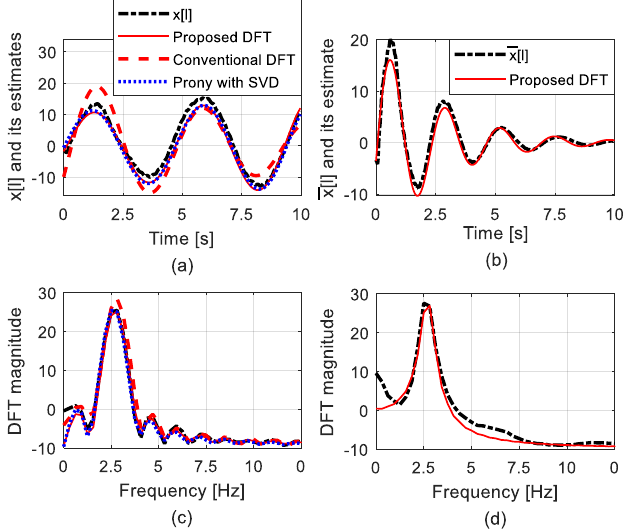
Figure 8. Modal oscillation signal and its estimated signals in the Central American power system: ( a ) 𝑥[𝑙] of the first segment and its estimated signals; ( b ) 𝑥 ̅[ 𝑙 ] of the first two combined segments and its estimated signal; ( c ) DFT magnitudes of the signals in (a); ( d ) DFT magnitudes of the signals in ( b ).